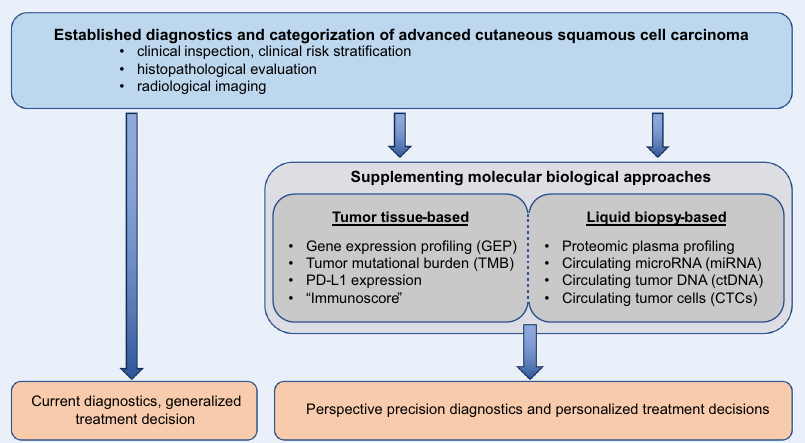
Fig. 1 Current and perspective diagnostic concepts in advanced cSCC. Schematic illustration of current diagnostic key elements and perspective supplementary value of tumor tissue- and liquid biopsy-based molecular biological